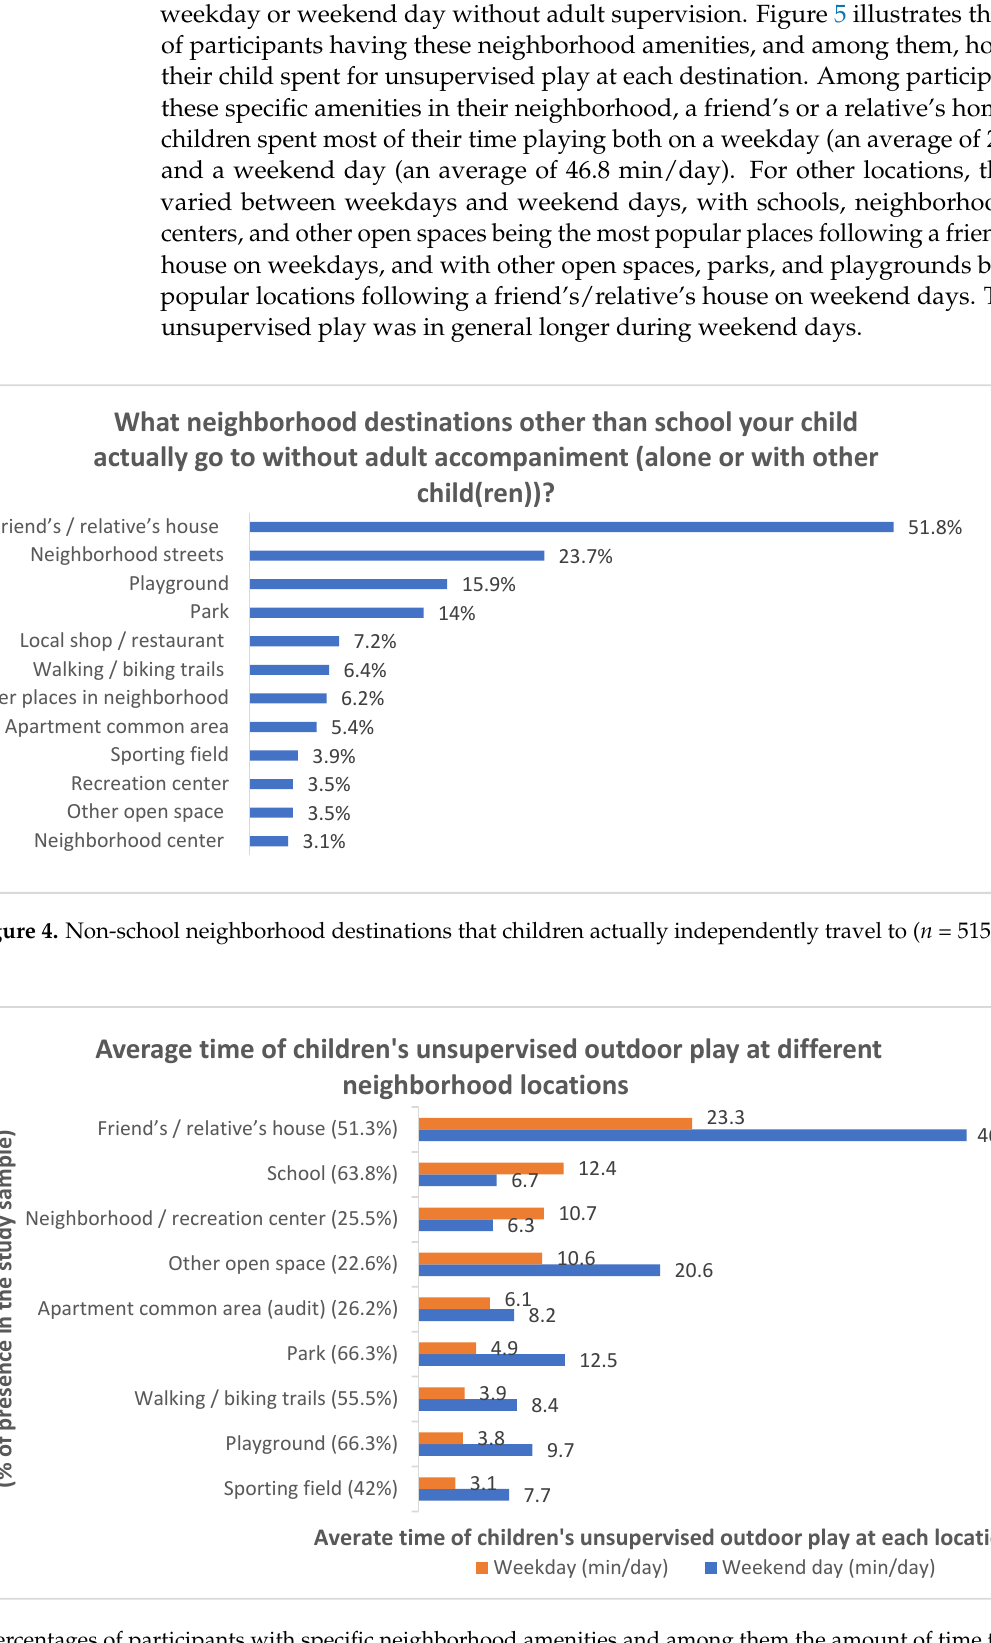
Figure 3. Parental license for independent travel and unsupervised outdoor play (second to fifth grade).